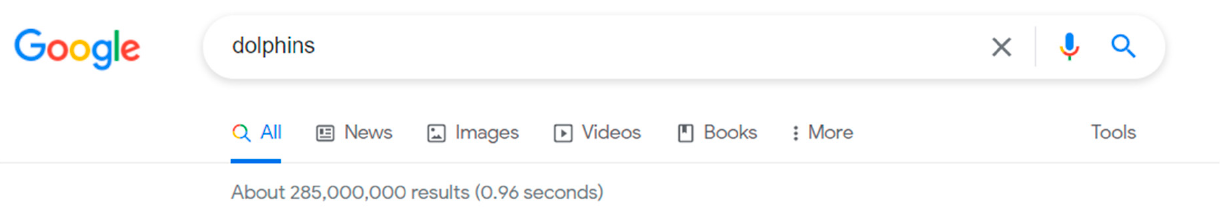
Figure 1. Google search result.